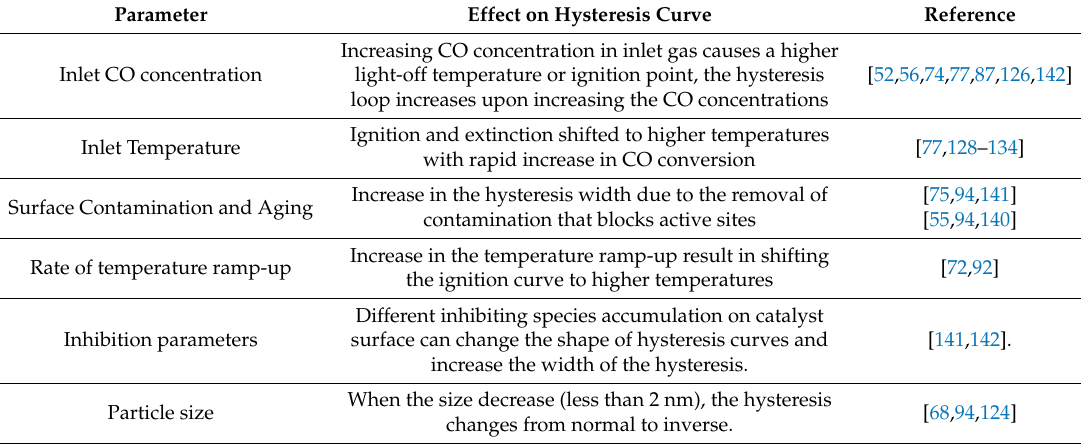
Table 2. Summary of the critical parameters and their effect on the exhibited